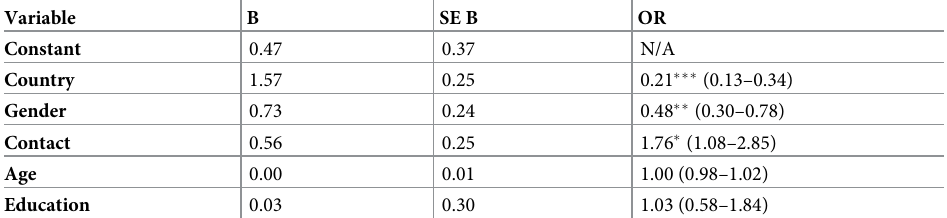
Table 5. Odds ratios (95% confidence intervals) from logistic regression analyses: Effects of socio-demographic characteristics and contact on the likelihood of identifying intellectual